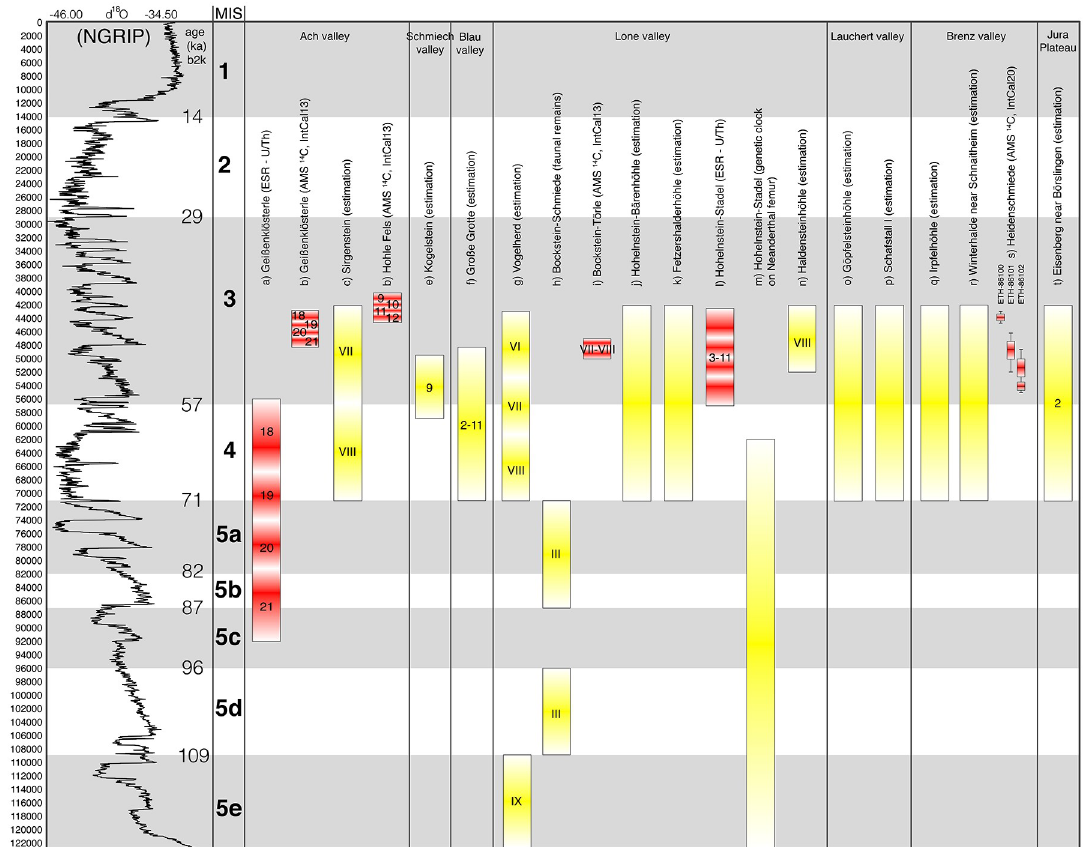
Fig 2. Radiometric dating and chronological classification of the Middle Paleolithic of the Swabian Jura. Legend: Oxygen isotope according to NGRIP [80], Greenland interstadials according to Rasmussen et al. [81]; a) Geißenklo¨sterle (ESR—U/Th) [70], b) Geißenklo¨sterle (AMS 14 C) [75], c) Sirgenstein (estimates) [41], d) Hohle Fels (AMS 14 C) [82,83], e) Kogelstein (estimates) [51], f) Große Grotte (estimates) [84], g) Vogelherd (estimates) [41,42],h) Bockstein-Schmiede (Fauna) [52], i) Bockstein-To¨rle (AMS 14 C) [73,74], j) Hohlenstein-Ba¨renho¨hle (estimates) [85], k) Fetzershalderho¨hle (estimates) [86], l) Hohlenstein-Stadel (Fauna and Sediment) [76], m) Hohlenstein-Stadel (genetic clock from Neanderthal femur) [79], n) Haldensteinho¨hle (estimates) [87], o) Go¨pfelsteinho¨hle (estimates) [88,89], p) Schafstall I (estimates) [88,89],q) Irpfelho¨hle (estimates) [90], r) Winderhalde bei Schnaitheim (estimates) [91], s) Heidenschmiede (AMS 14 C, this study and Mu¨nzel & C¸ep in press) and t) Eisenberg near Bo¨rslingen (estimates) [43,46,92].Red bars— radiometric dating (ESR—U/Th and AMS 14 C) and yellow bars—estimates.